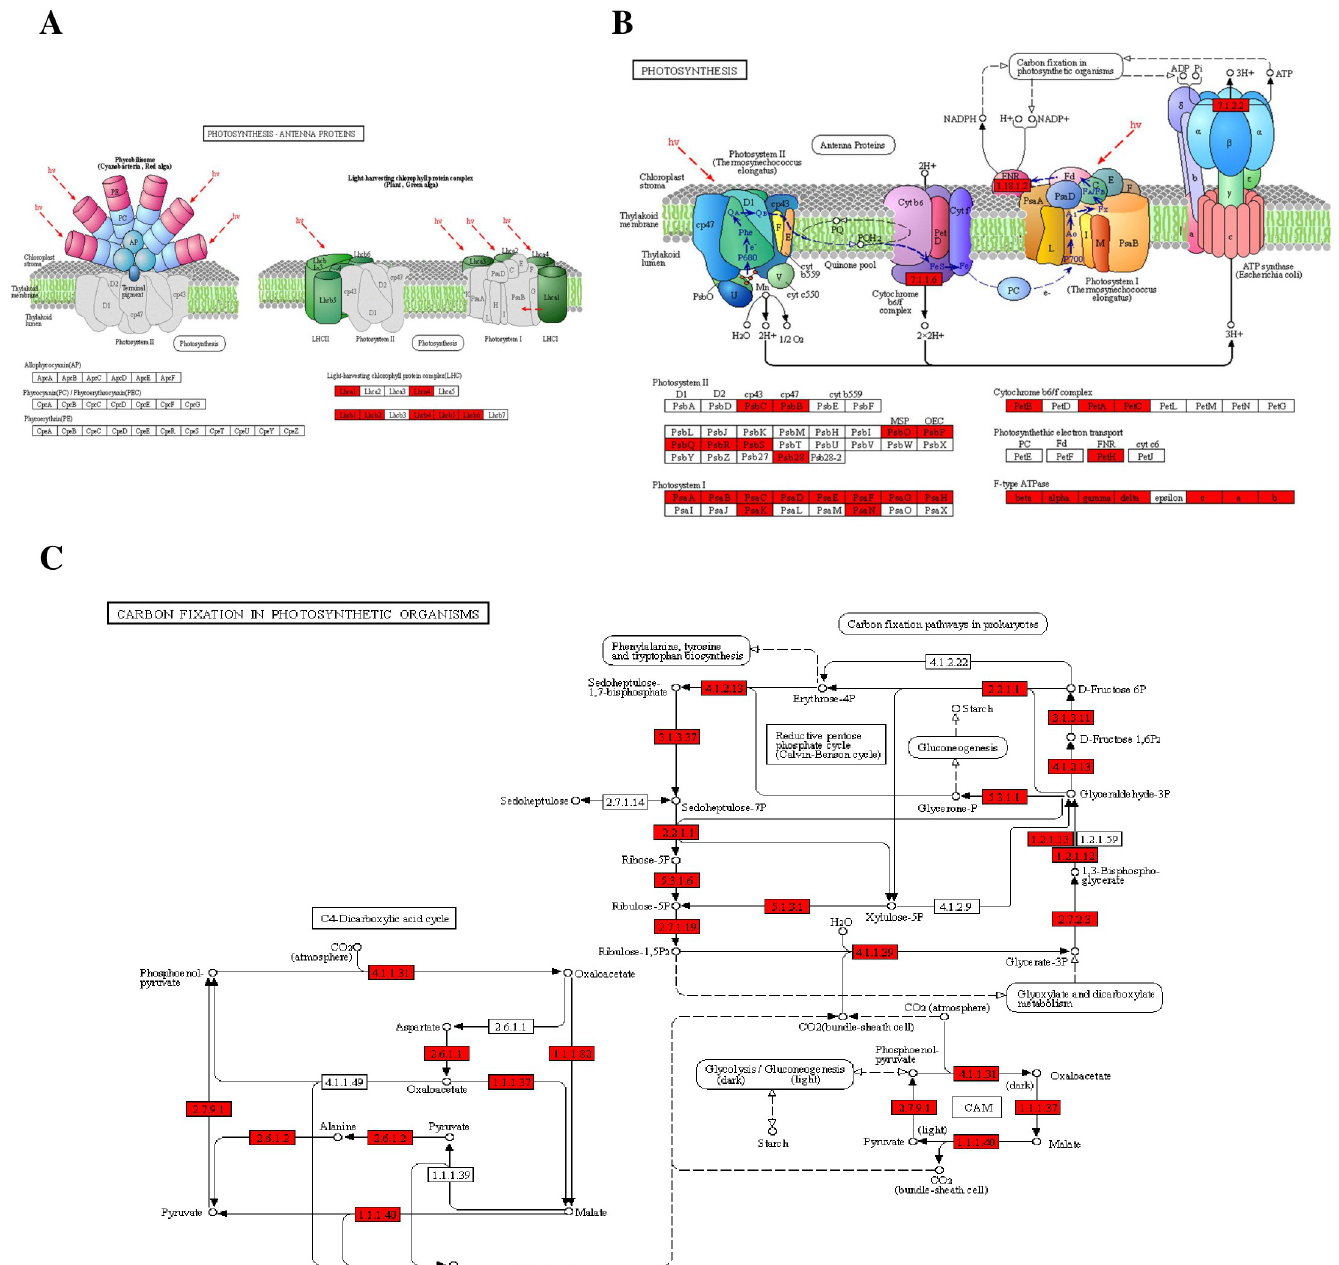
Fig 6. Representative significantly enriched photosynthesis related KEGG pathways. (A) Photosynthesis-Antenna proteins. (B) Photosynthesis. (C) Carbon fixation in photosynthetic organisms. The Khib proteins were labeled in red.